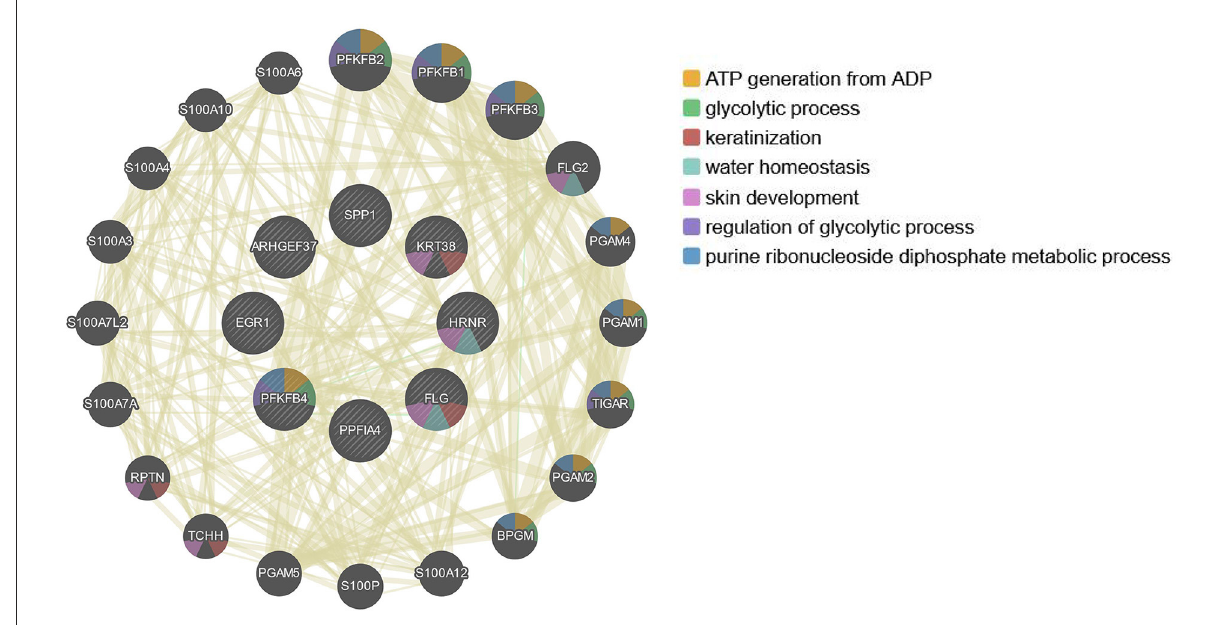
FIGURE5 Relation network of the twelve hub genes analyzed by